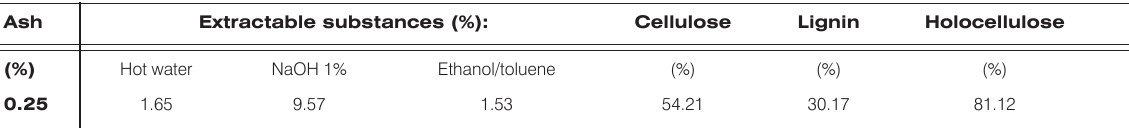
Table 1. The main chemical components of Abies alba softwood. Ash Extractable substances